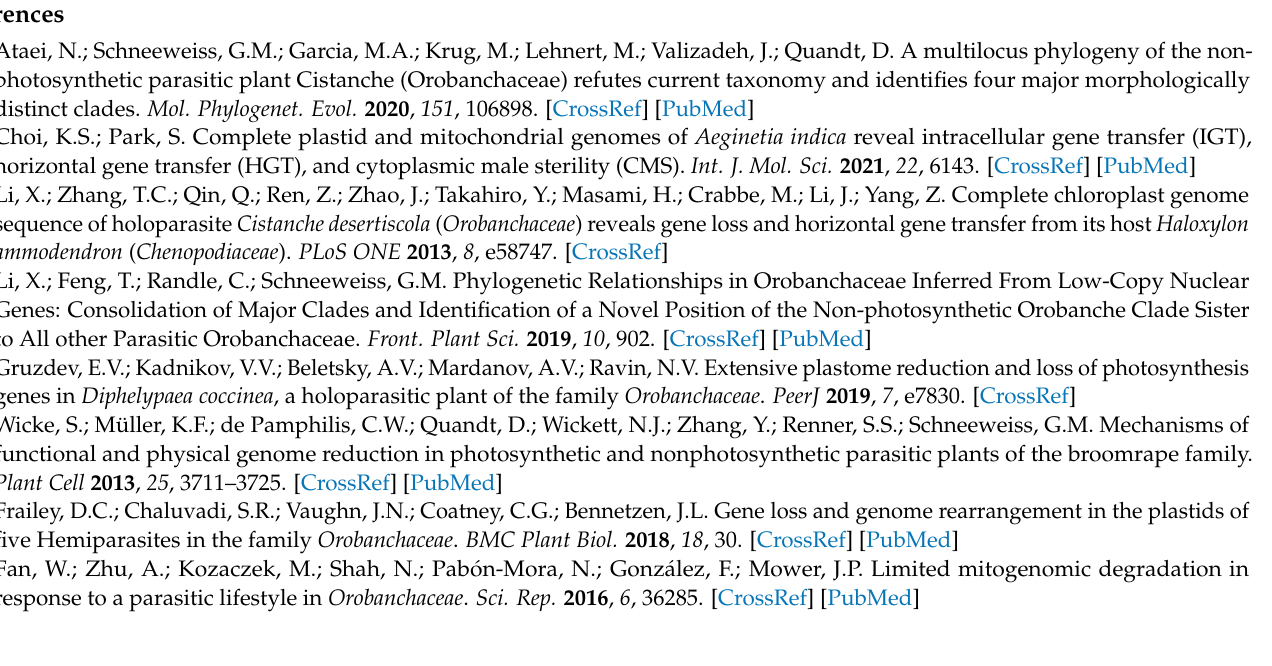
Table S17: Segment duplication sequences in C. deserticola mitogenome; Table S18: Segment duplication sequences in C. salsa mitogenome; Table S19: Segment duplication sequences in C. tubulosa mitogenome; Table S20: Pairwise Ka/Ks ratios in different mitochondrial genes of 11 Lamiales